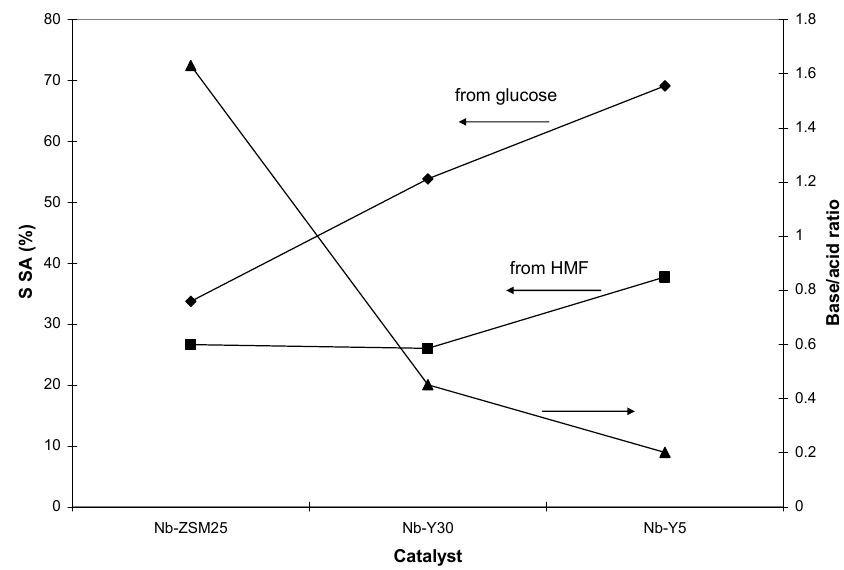
Figure 7. The variation of the SA selectivities as a function of the catalyst nature and the base/acid ratio.